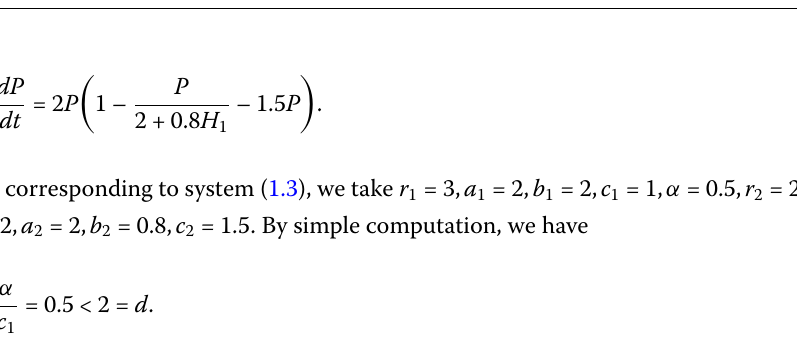
Figure 2 Dynamic behaviors of the weak partners in system (5.1). The initial conditions (